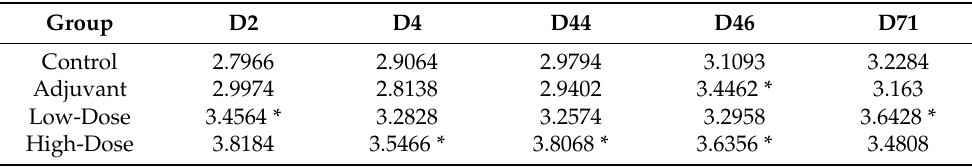
Table 3. Changes in FIB of animals in each group